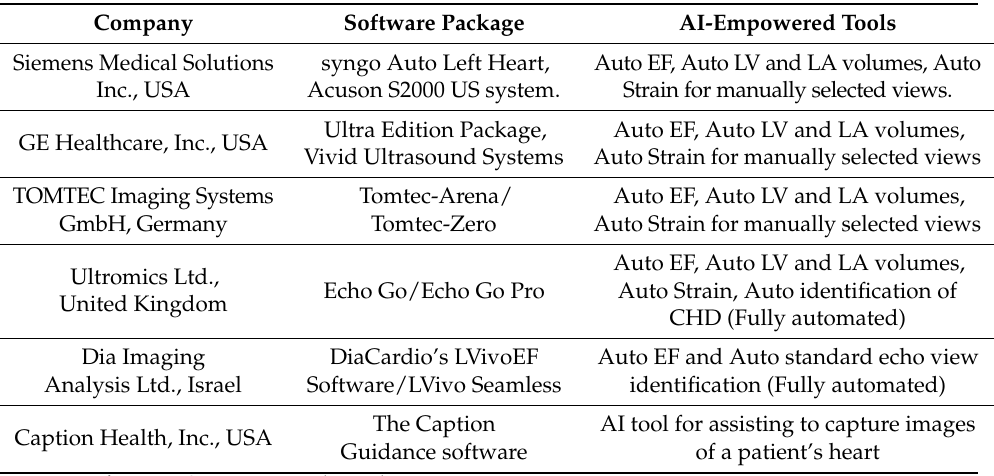
Table 1. The list of commercial software packages that provides automated measurements or